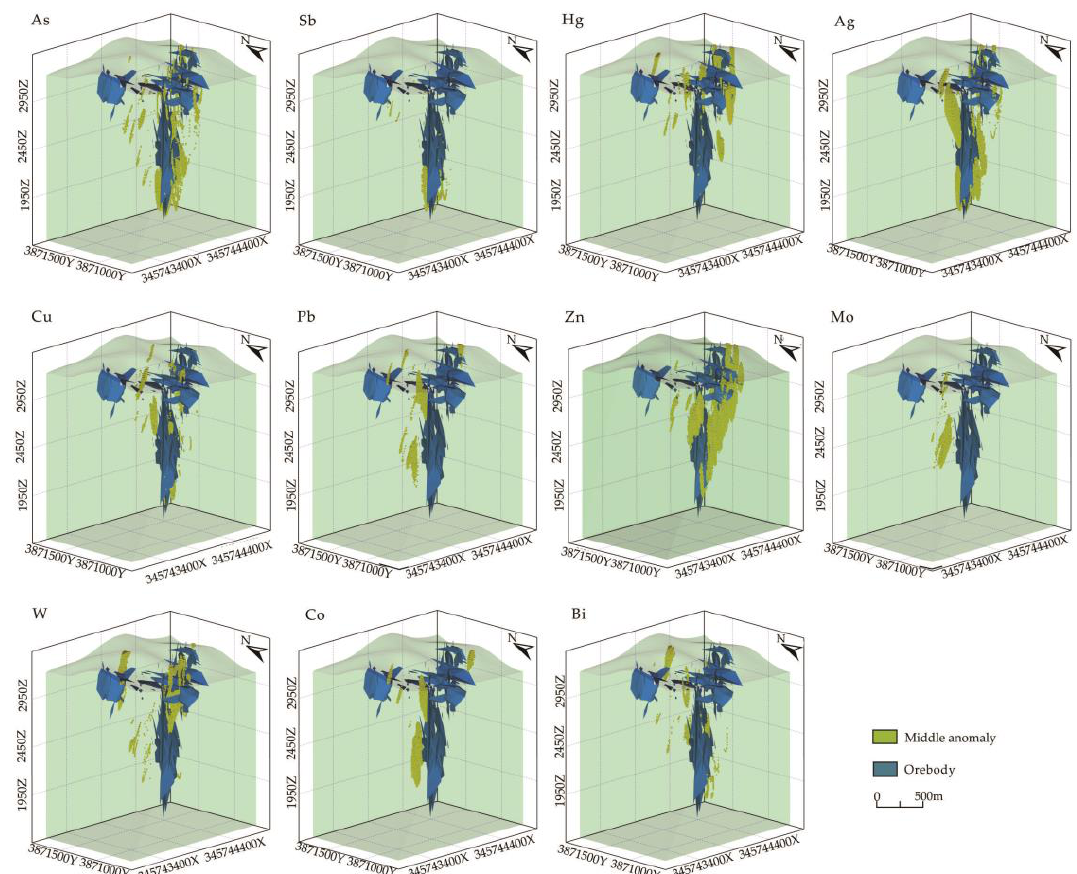
Figure 9. The middle anomalies distribution in Zaozigou gold deposit.